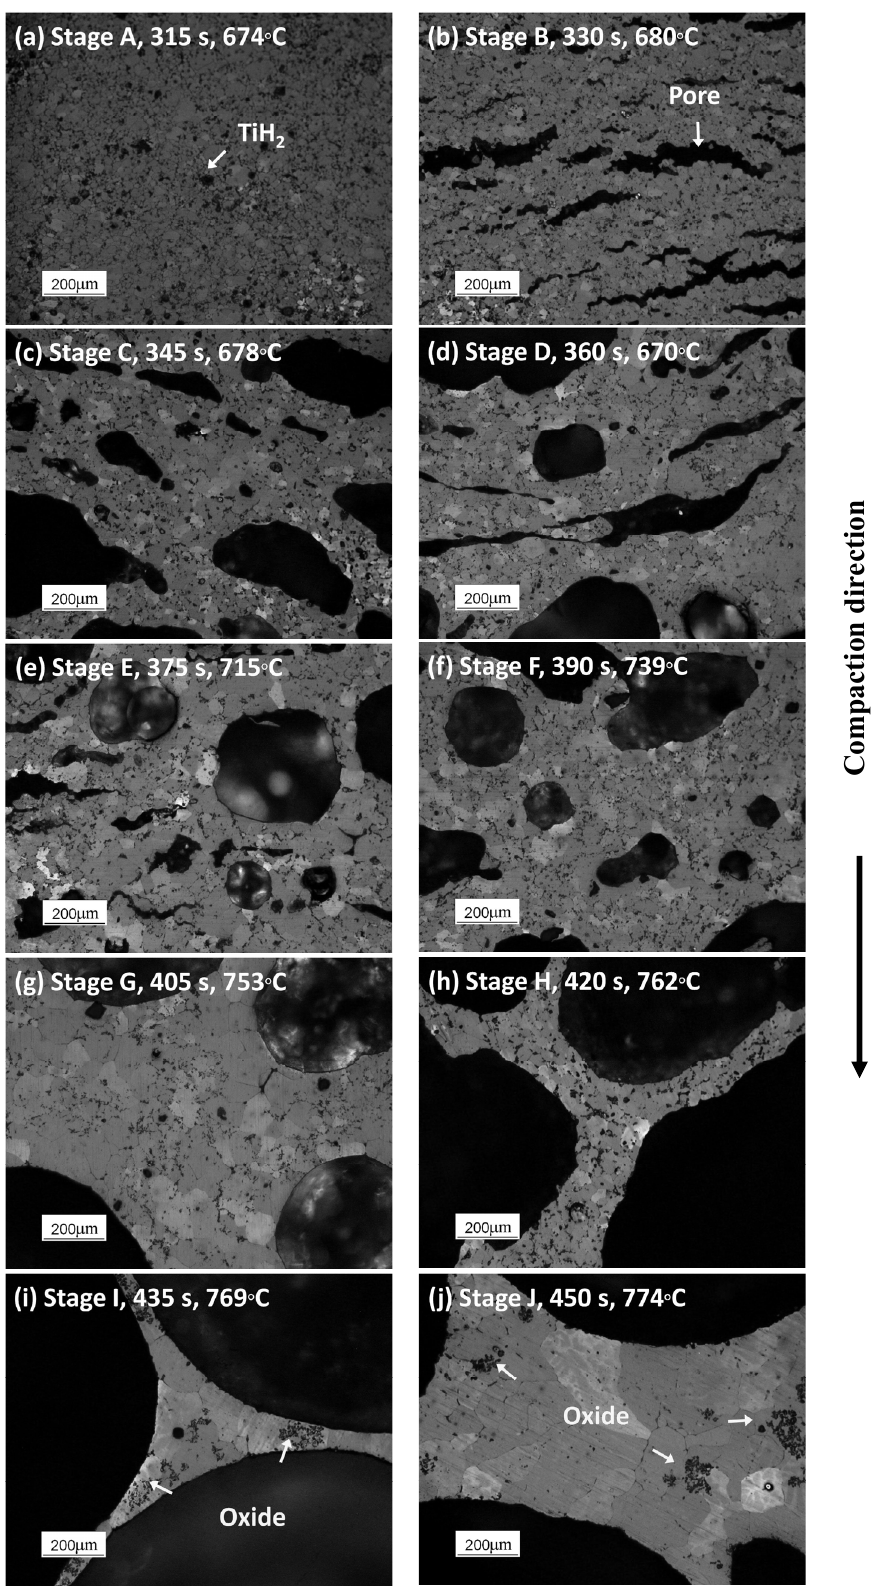
Figure 4. Optical micrographs showing microstructural development at different temperature and